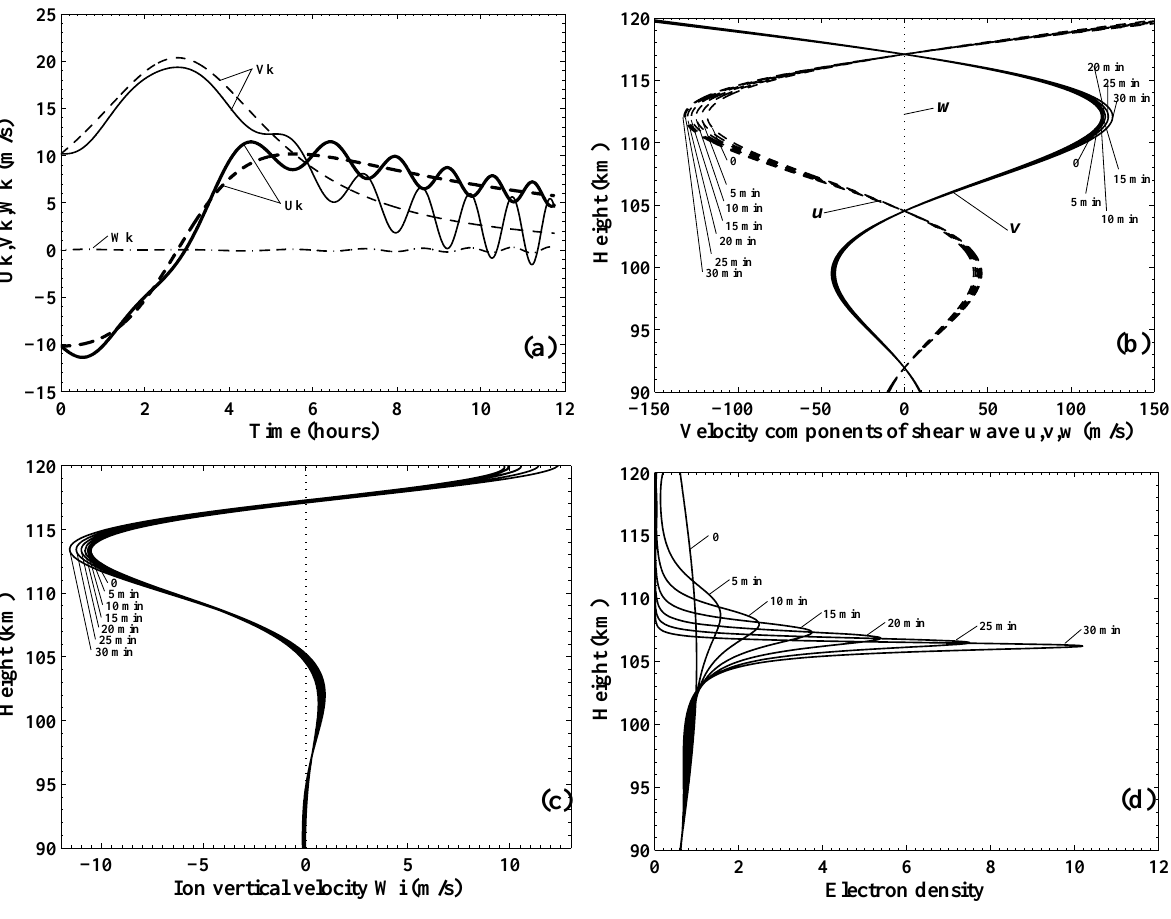
Fig. 1. (a) Temporal development of the shear wave velocity spatial amplitudes (at h = h 0 = 82km) U k (t) dark dashed line – analytical approach, dark solid line – numerical simulation), V k (t) (dashed line – analytical approach, solid line – numerical simulation) and W k (t) (dash-dotted line), (b) height variations of horizontal u(h,t) (dashed line), v (h,t) (solid line) and vertical w(h,t) (dotted line) components of shear wave velocity, (c) height variations of the ion vertical drift velocity w i (h,t) and (d) the formation of a sporadic E layer (for electron density) for time intervals: t = 0, 5, 10, 15, 20, 25 and 30min in the horizontal shear flow. The linear shear a = 10 − 4 s − 1 and the shear wave horizontal and vertical wavelengths λ x = λ y = 754km and λ z = 25km,